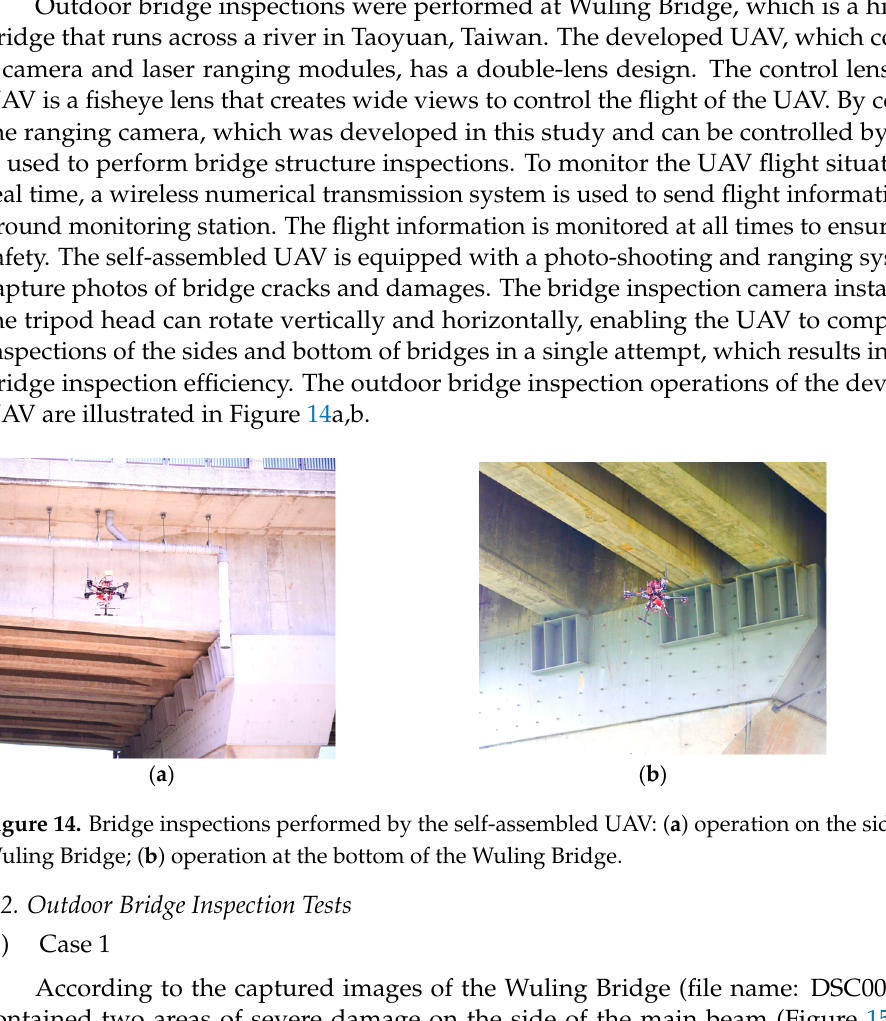
( b ) Figure 15. Damage on the side of the main beam at the test site: ( a ) connected concrete cracks; ( b ) unconnected concrete cracks. ( a ) ( d ) Figure 16. Crack identification: ( a ) original image; ( b ) binary image; ( c ) image obtained after noise removal and skeletonization; ( d ) main cracks.